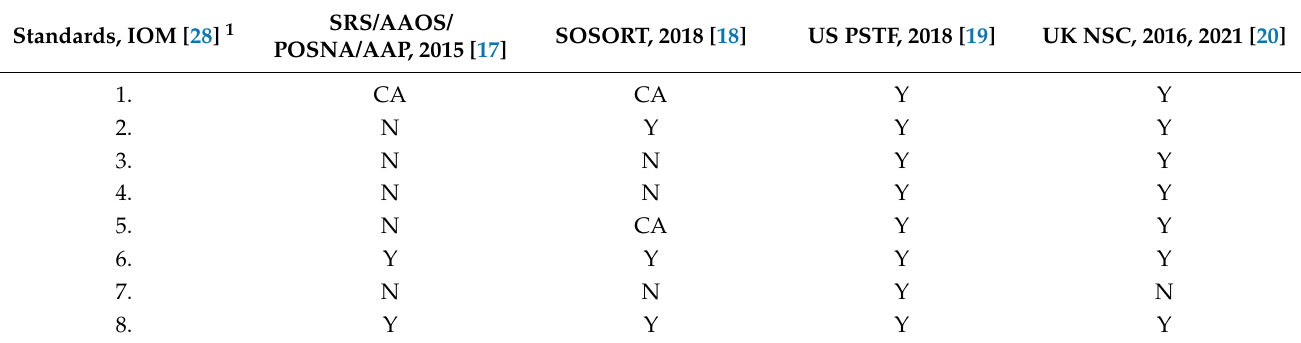
Table 2. Assessment of the standards of trustworthiness of the included recommendation documents, using the criteria of the Institute of Medicine, IOM [28].